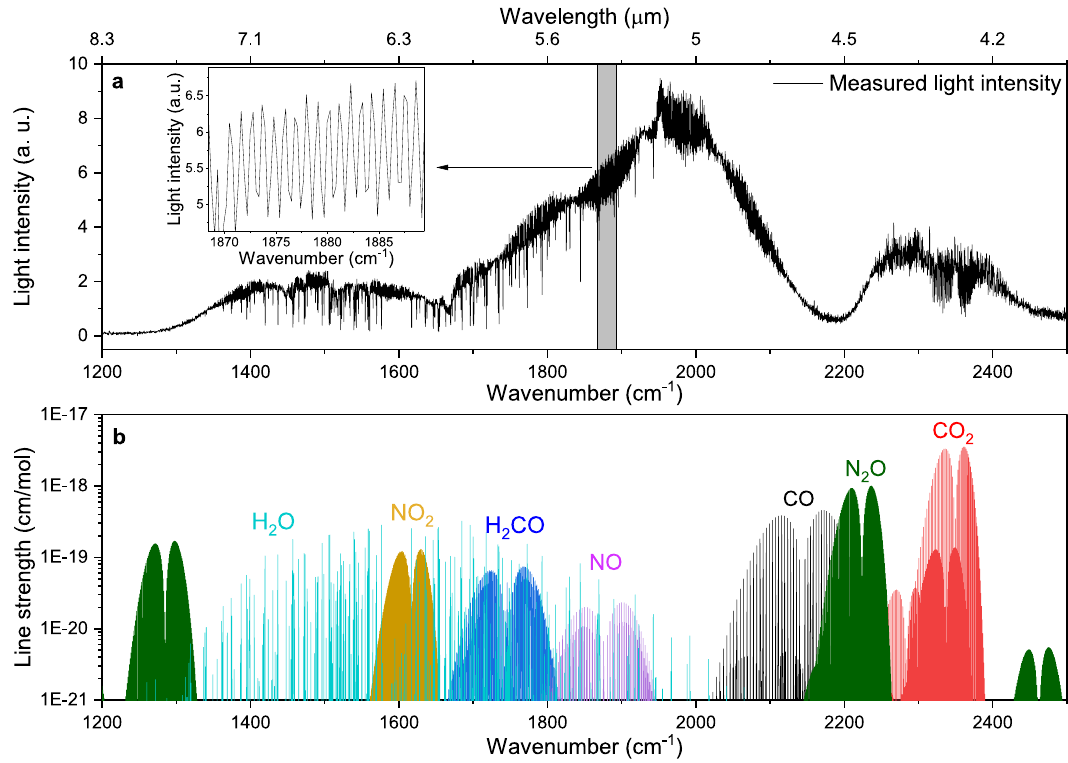
Figure 2. Spectral coverage of the MIR SC source and absorbing molecular species. ( a ) The spectrum of the MIR SC source with a spectral resolution of ~ 0.27 cm −1 (8 GHz) measured under vacuum conditions, insert: an enlargement of the spectrum, showing the etalon fringes in the measured spectrum. ( b ) Simulated spectral line intensity of different species from HITRAN2020 between 1300 cm −1 and 2500 cm −1 .